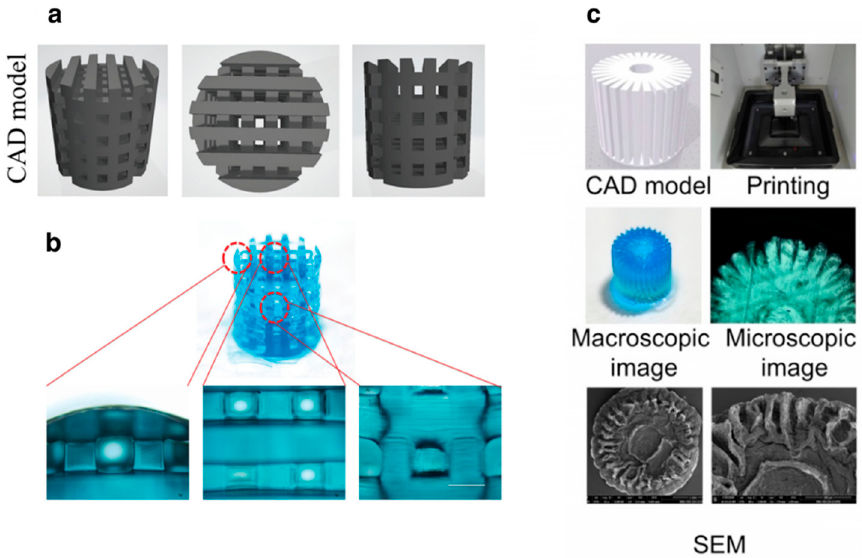
Figure 13. 3D-printed scaffolds for OCTE. ( a ) Computer-aided design (CAD) model of a PEGDA/dECM scaffold. ( b ) Macroscopic image of the 3D-printed PEGDA/dECM scaffold. Scale bar: 0.7 mm. Adapted with permission from [329]. Copyright © 2020, SAGE Publications. ( c ) 3D printing process, macroscopic, microscopic, and SEM imaging of the radially-oriented exosome-loaded GelMA/dECM scaffold. Adapted from [333] under the terms of the Creative Commons Attribution- NonCommercial (CC BY-NC) license (https://creativecommons.org/licenses/by-nc/4.0/). Copyright © 2021, Ivyspring International Publisher.